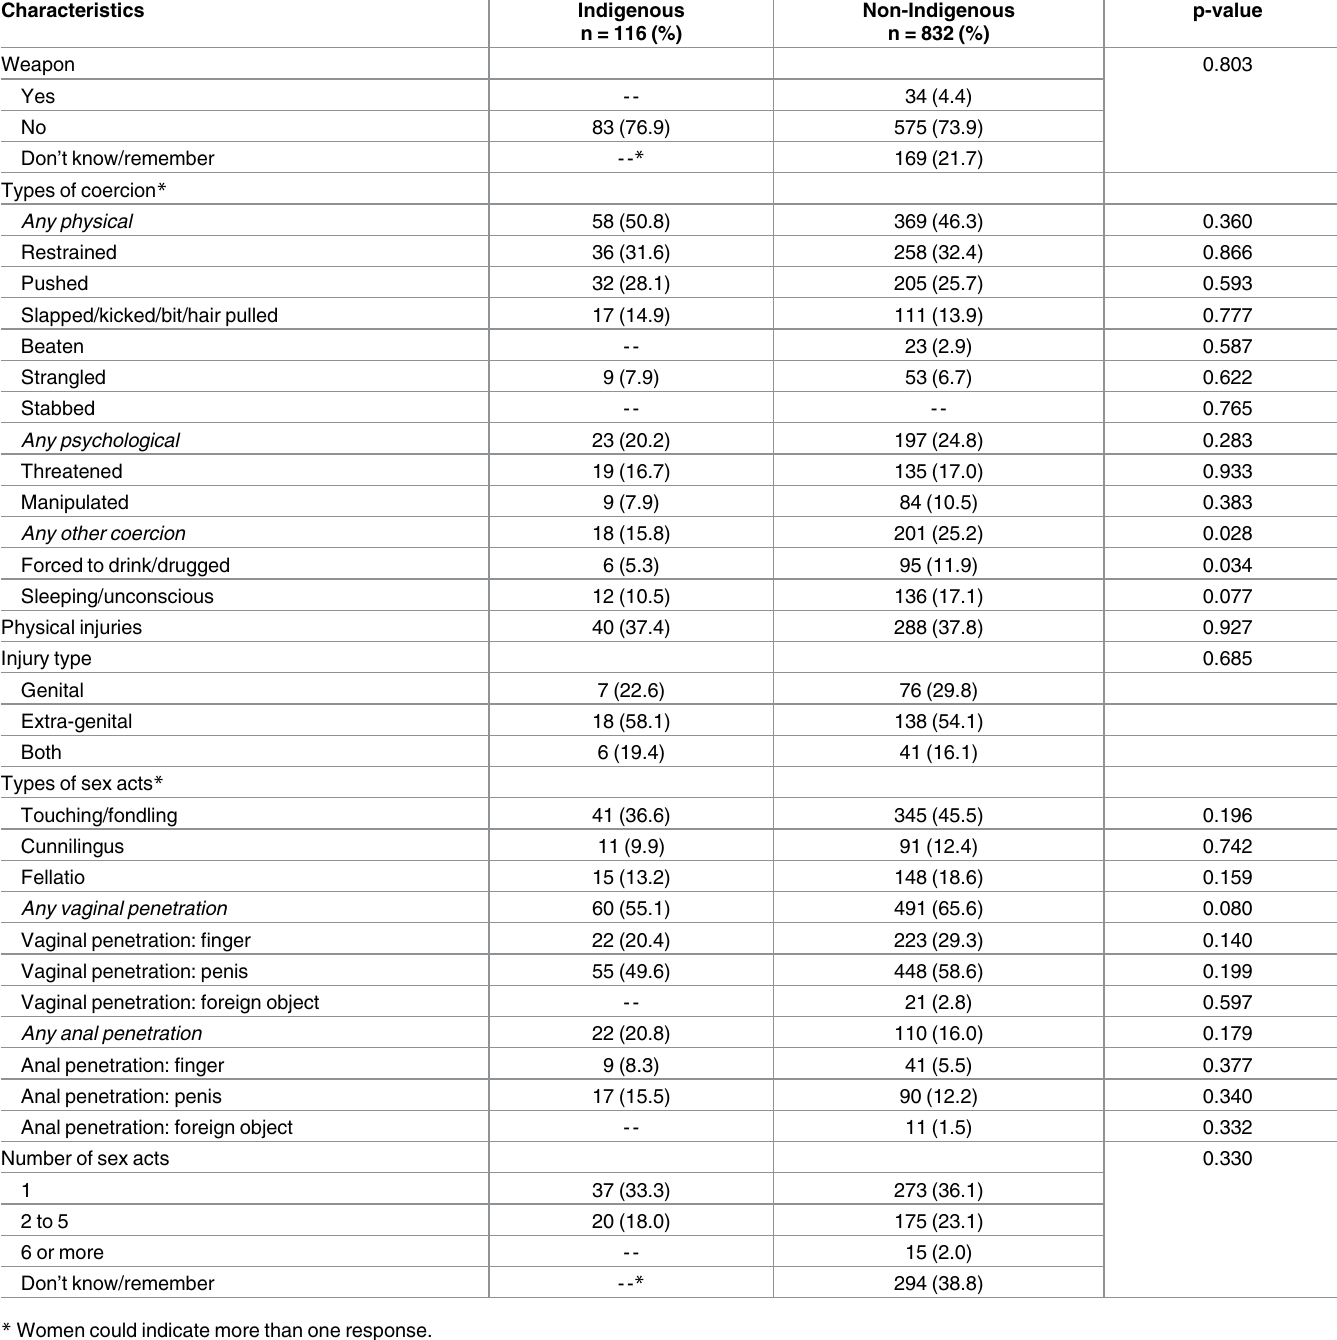
Table 4. Assault characteristics of sexually assaulted adolescent and adult women who presented to Sexual Assault/Domestic Violence Treat- ment Centres, by Indigenous status.